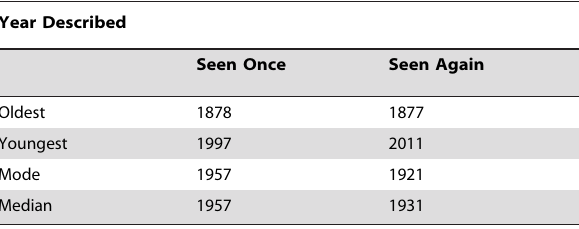
Table 2. Year in which Gymnodinium species were described for oncers and species that have been observed in multiple